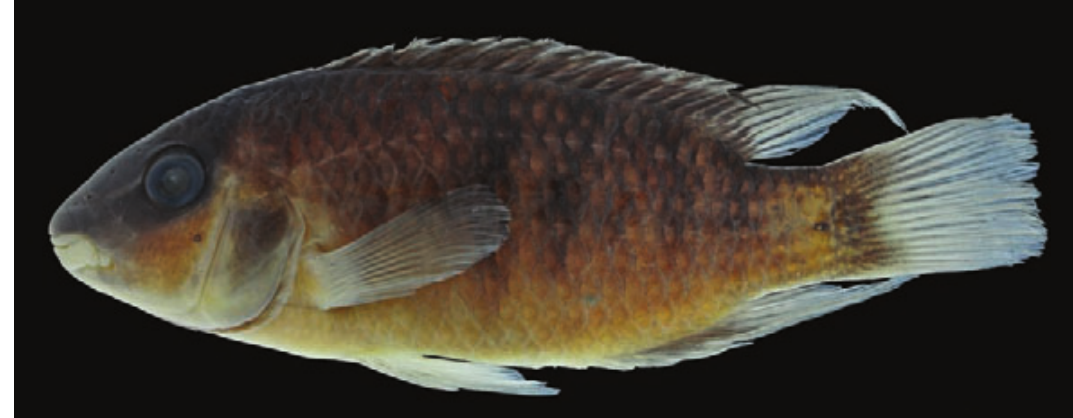
Fig. 8. Mazarunia charadrica , holotype, UG/CSBD 1667, 65.2 mm SL, Guyana, Cuyuni-Mazaruni (Region 7), Waruma Creek, tributary of Kako River, upper Mazaruni River